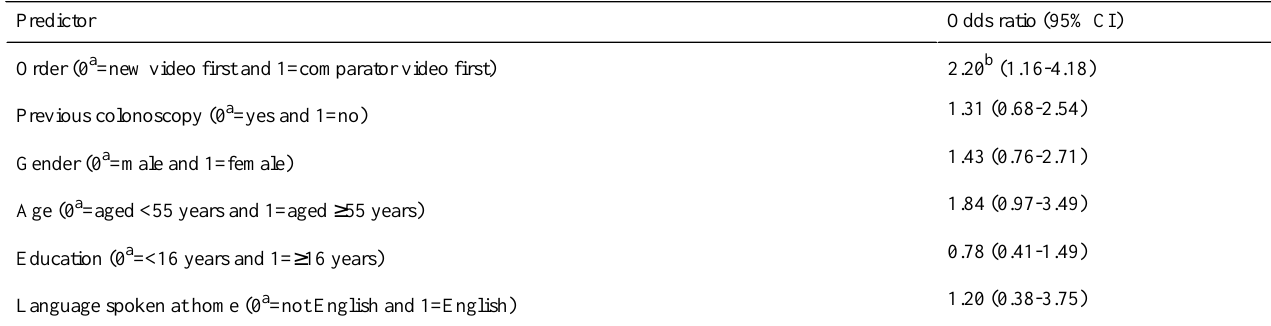
Table 4. Predictors of preference for new video (n=232).